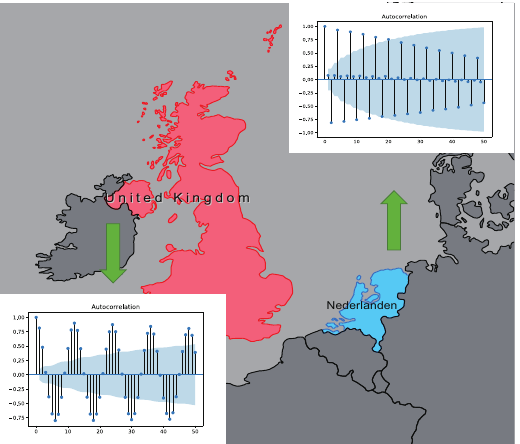
Figure 6. Geographical location of the UK and the Netherlands along with the autocorrelation of